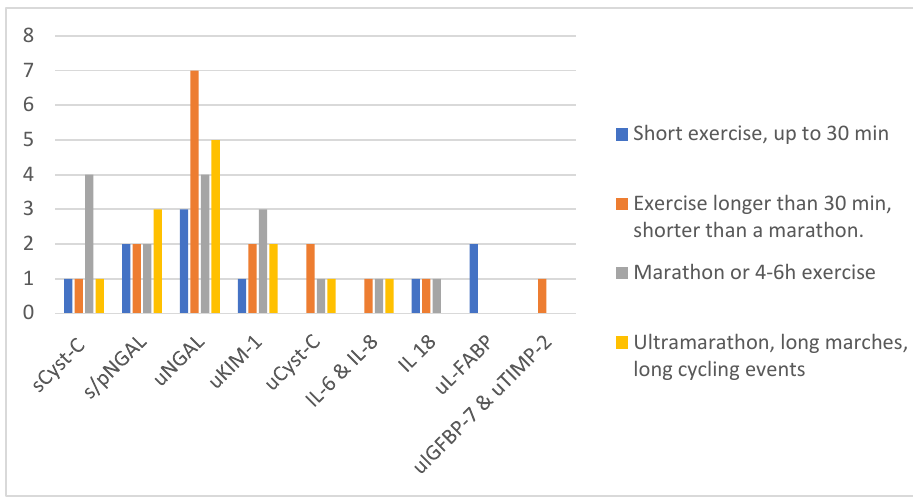
Figure 1. Number of studies in different types of exercise. Abbreviations: u—urinary, s—serum, p—